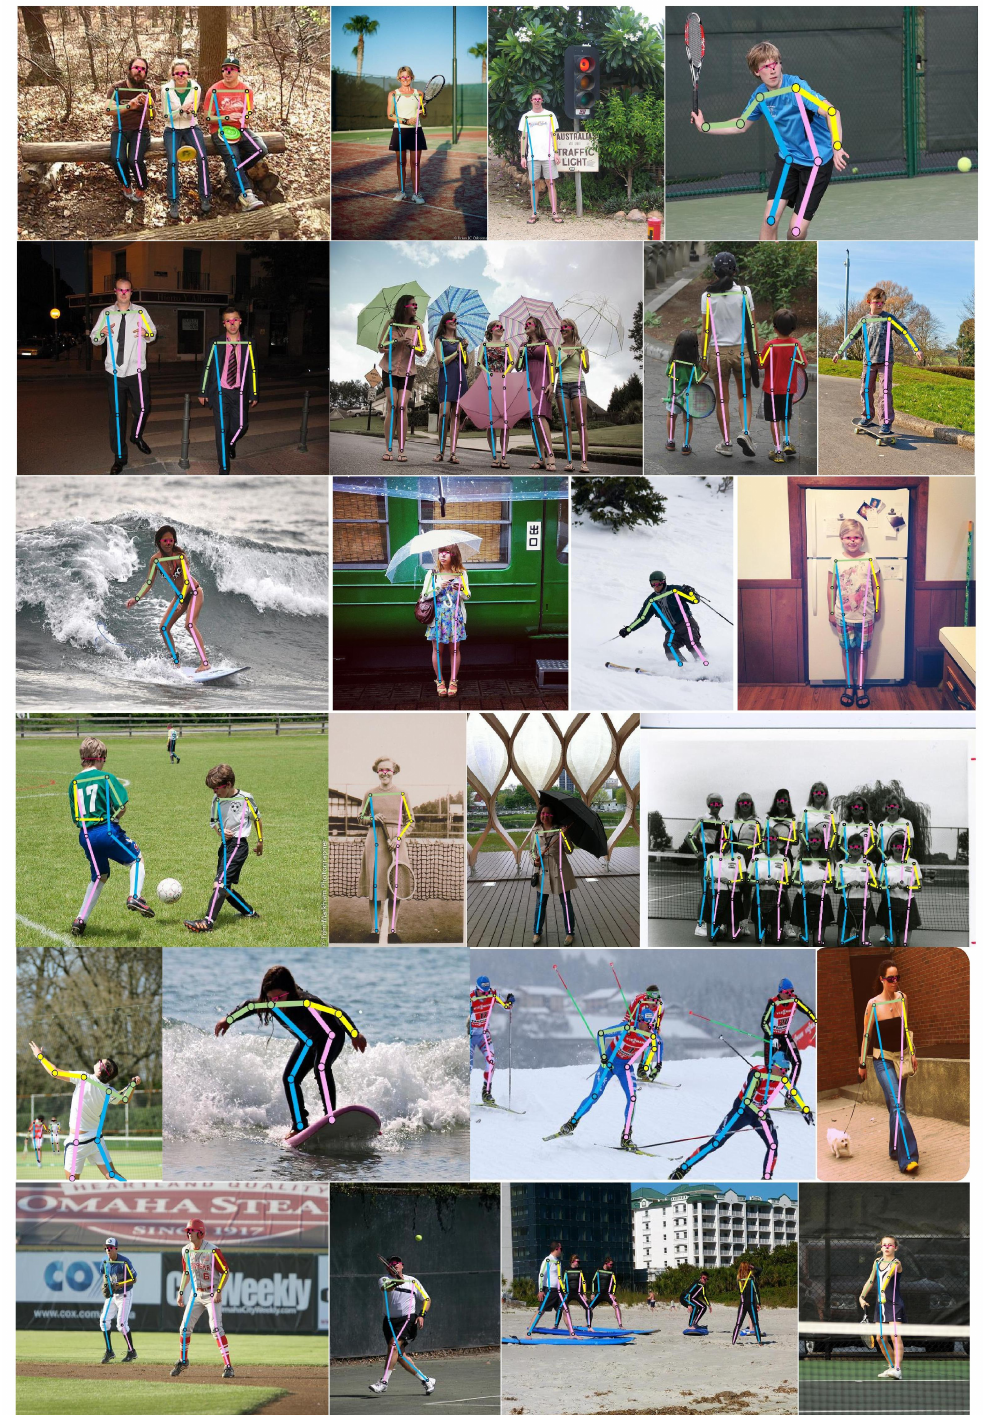
Figure 8. Qualitative estimated results of our model in more realistic